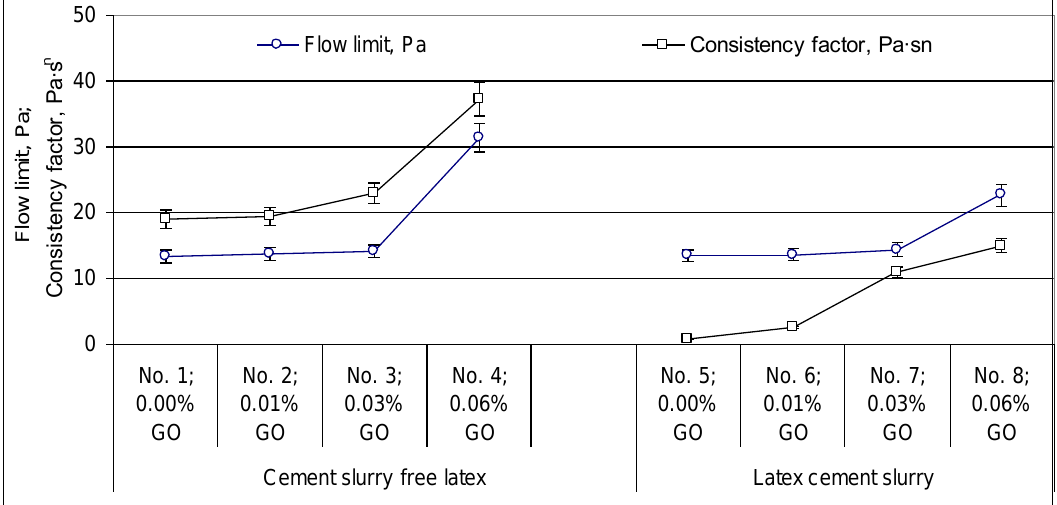
Figure 6. Flow limit and coefficient of consistency change versus the GO concentration.